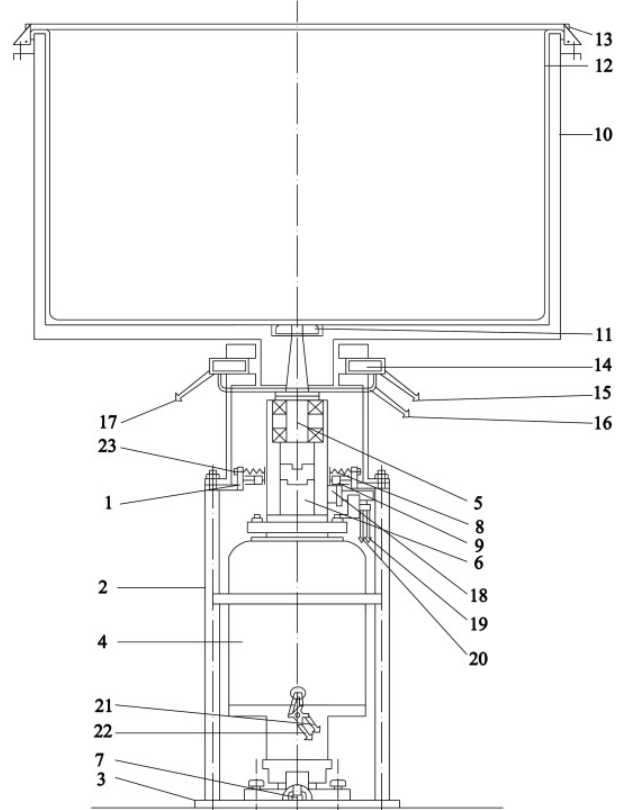
Figure 26. Gyroscopic rotor based